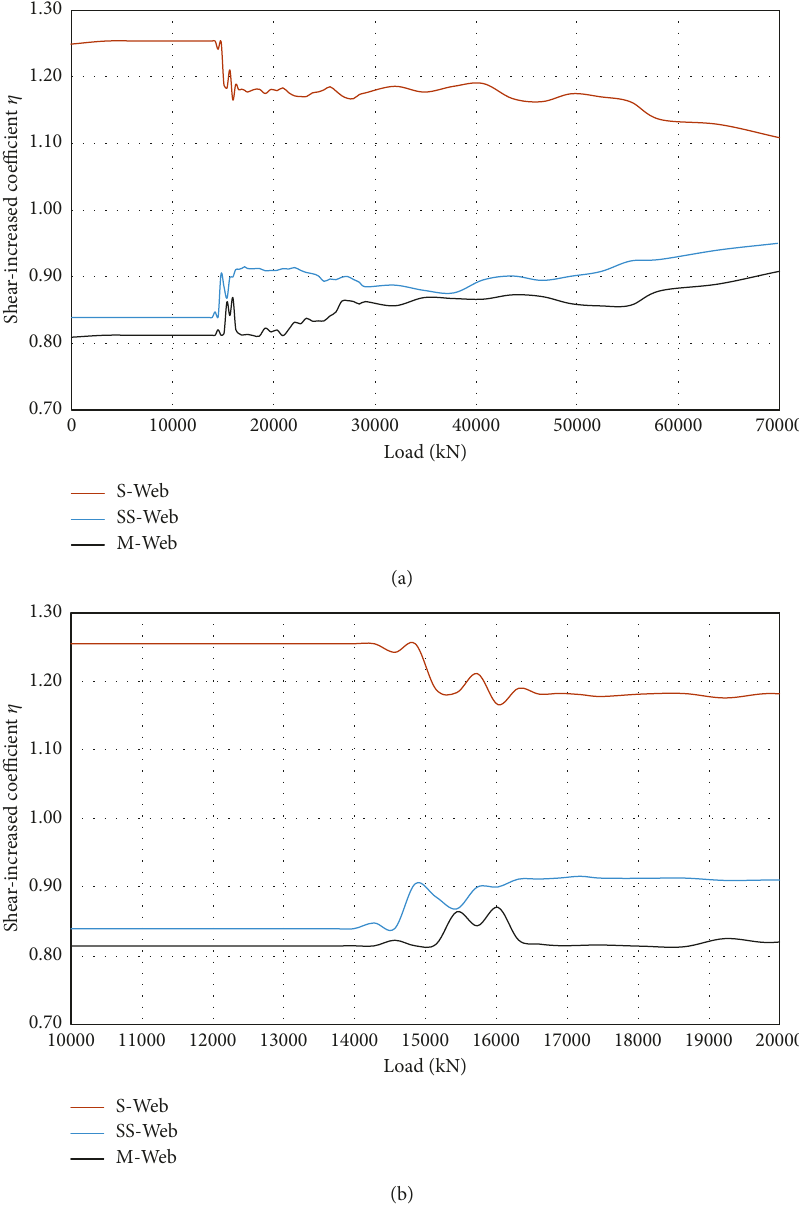
Figure 17: Shear-increased coefficient η of webs in section 9 with load. (a) Shear-increased coefficient η of webs (load: 0 ∼ 70500 kN). (b) Shear-increased coefficient η of webs (load: 10000 ∼ 20000